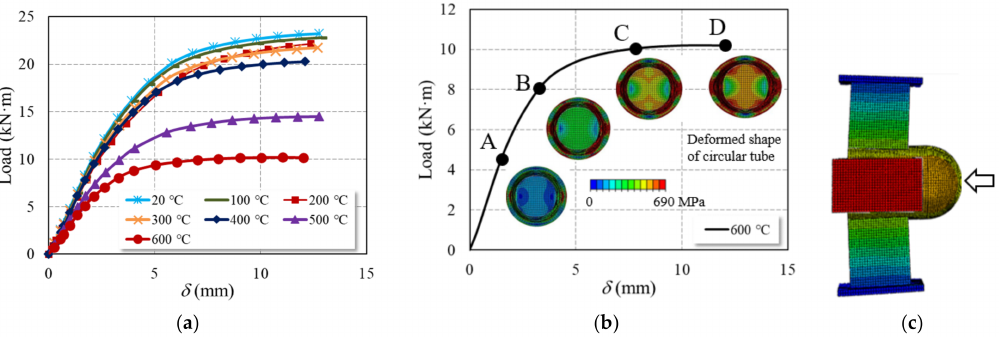
Figure 14. Effects of elevated temperatures on the load–displacement curves of specimen N1 under positive bending: ( a ) load–displacement curves; ( b ) failure process; ( c ) deformed shape corresponding to point